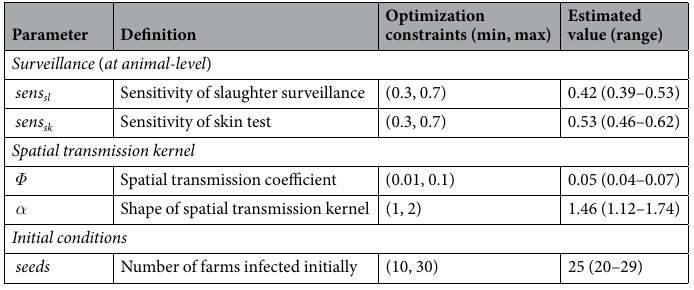
Table 1. Definitions, estimated values, and constraints for parameters undergoing optimization.